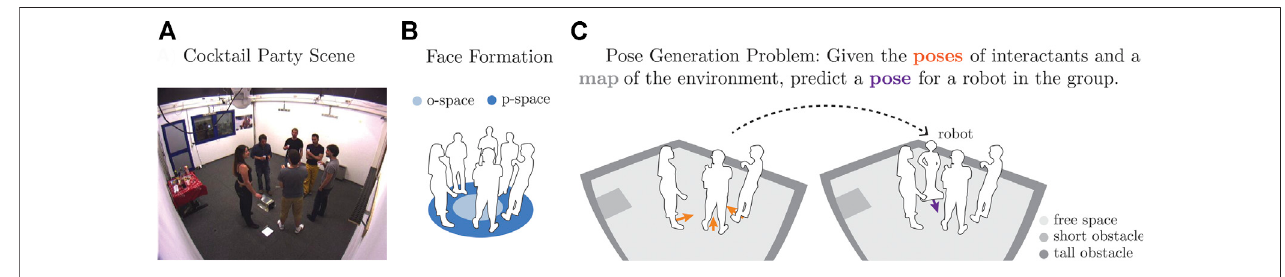
Frontiers in Robotics and AI |